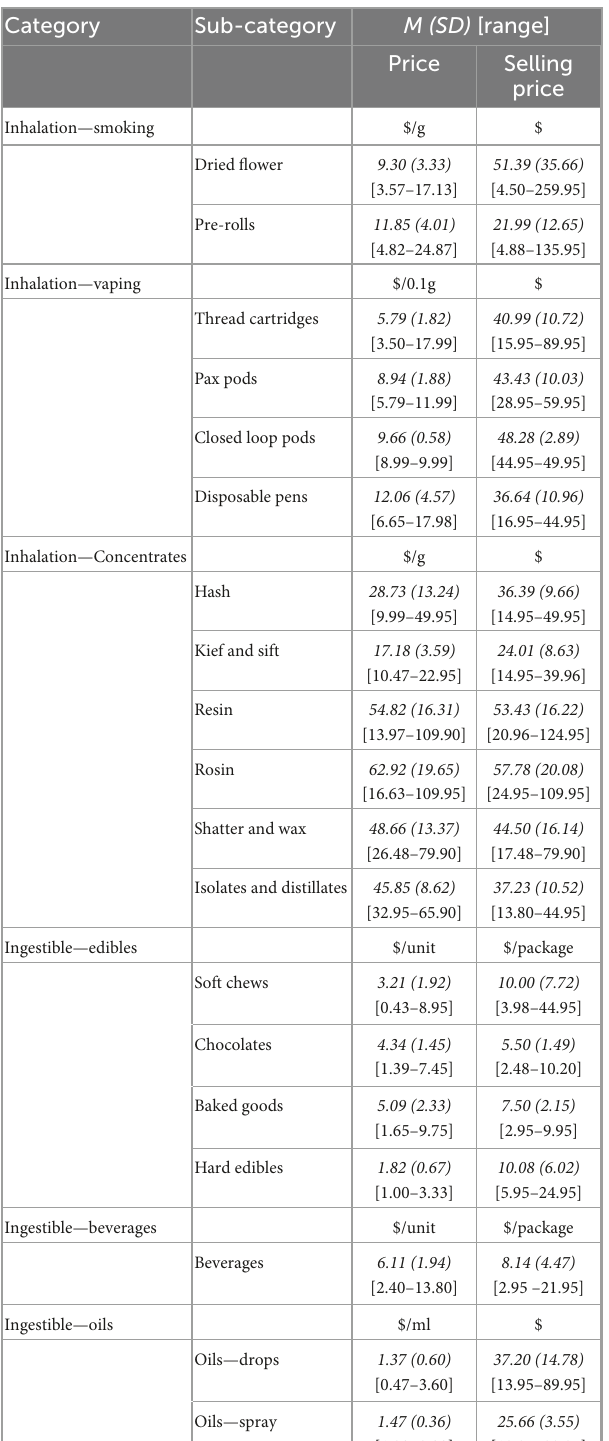
TABLE 4 Average prices by product type (first quarter of